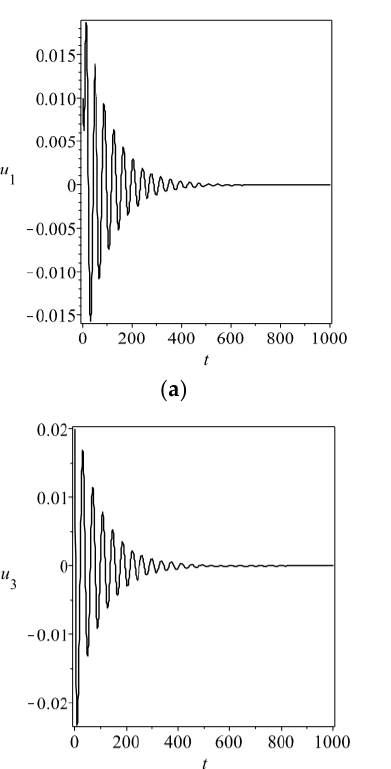
Figure 1. Dynamics of Equation (2) with